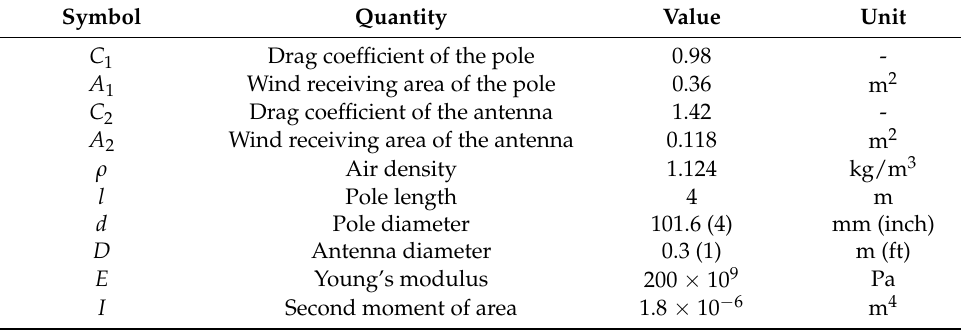
Table 2. Values of parameters for the calculation of inclination angle due to wind speed. Symbol Quantity Value Unit C 1 Drag coefficient of the pole 0.98 - A 1 Wind receiving area of the pole 0.36 m 2 C 2 Drag coefficient of the antenna 1.42 - A 2 Wind receiving area of the antenna 0.118 m 2 ρ l